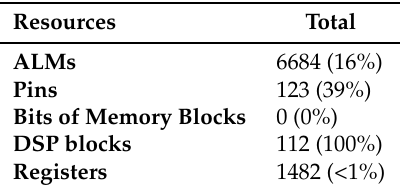
Table 6. Hardware resources used by the ANNM Module.